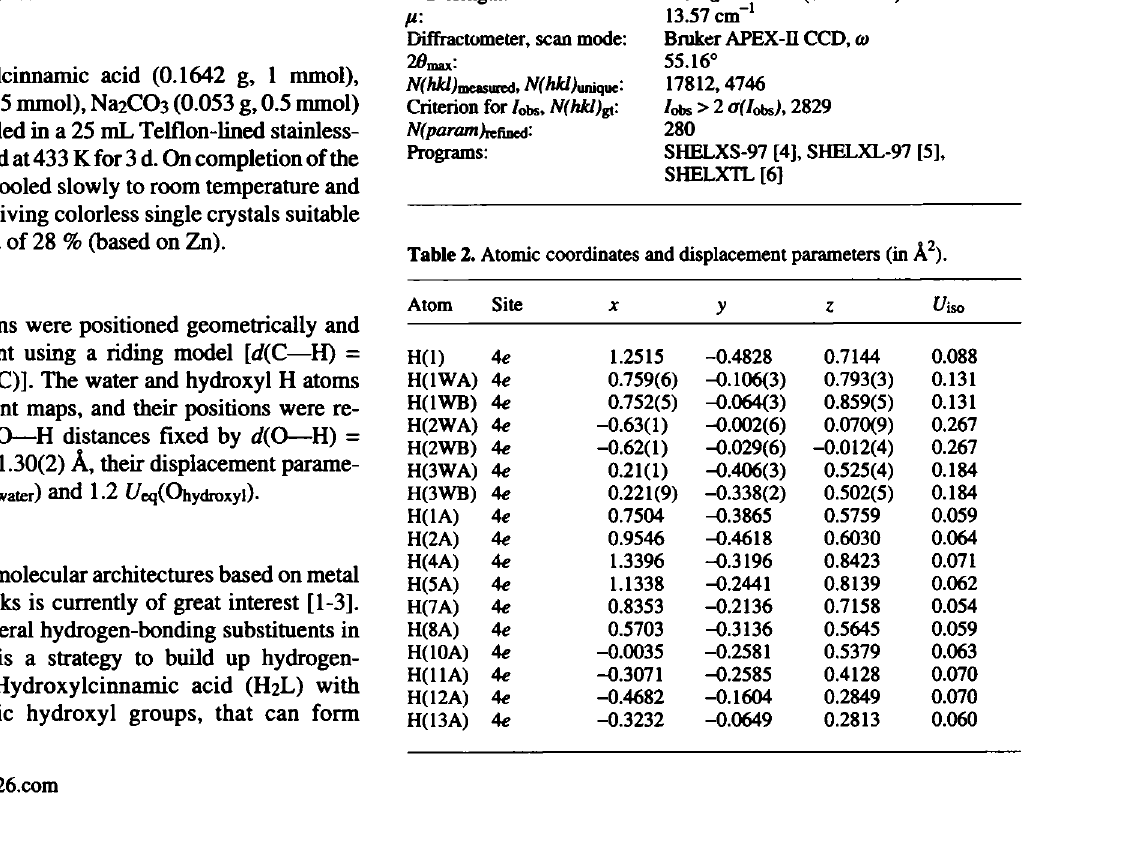
Table 1. Data collection and handling.